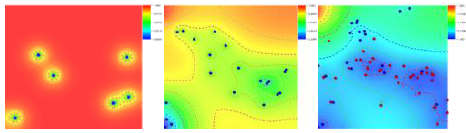
FIGURE 1: The dynamic interplay between mass transport and cellular proliferation inside a